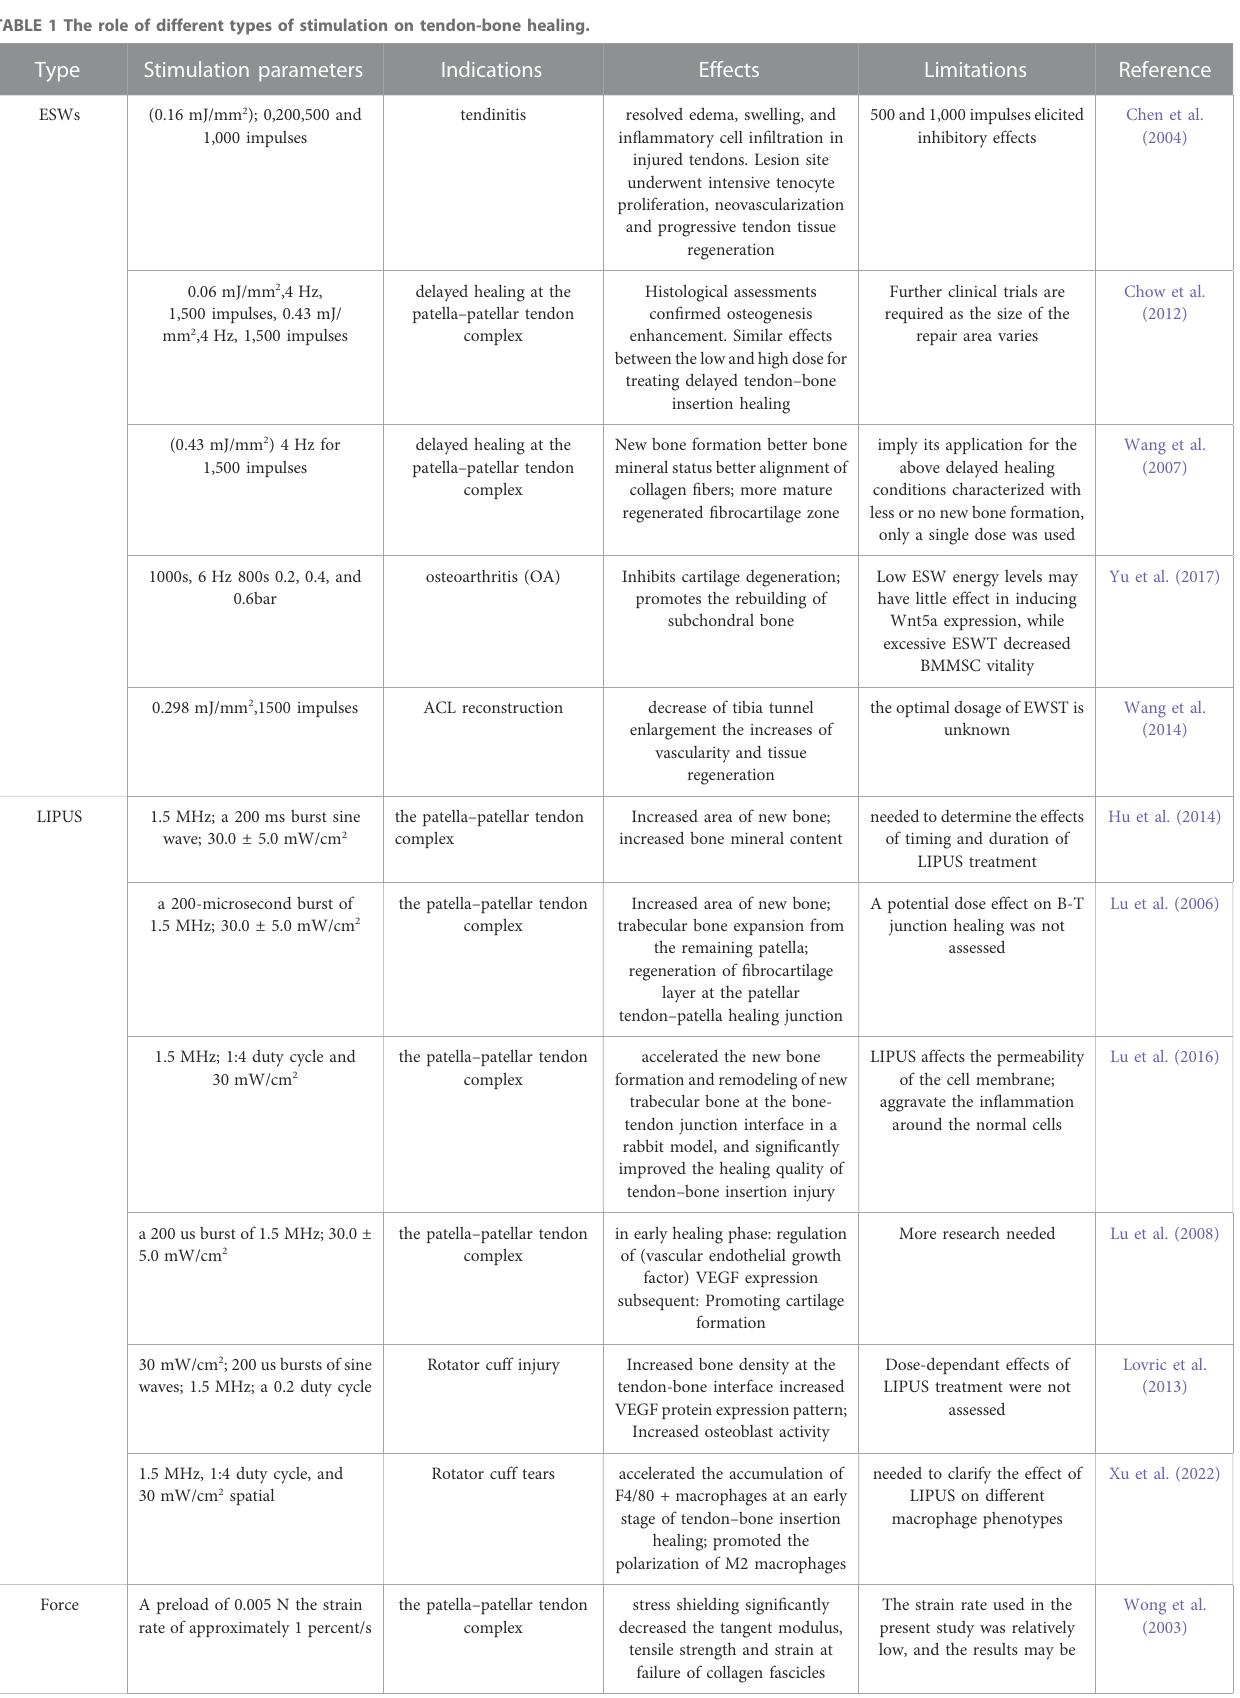
TABLE 1 The role of different types of stimulation on tendon-bone